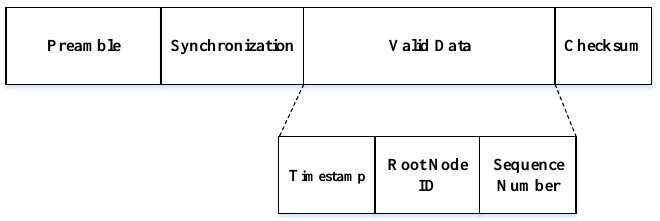
Figure 2. Flooding time synchronization protocol (FTSP)